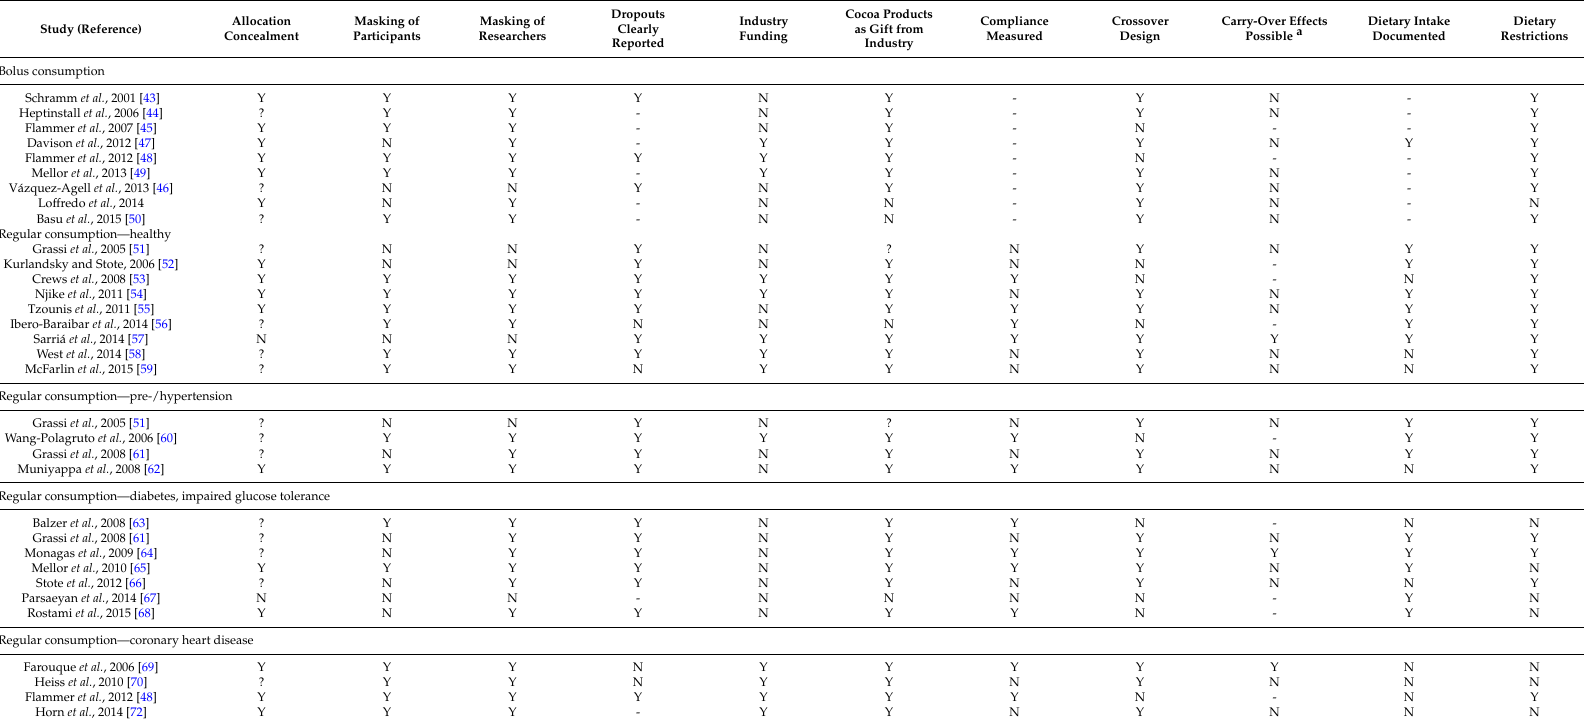
Table 6. Quality of randomized controlled